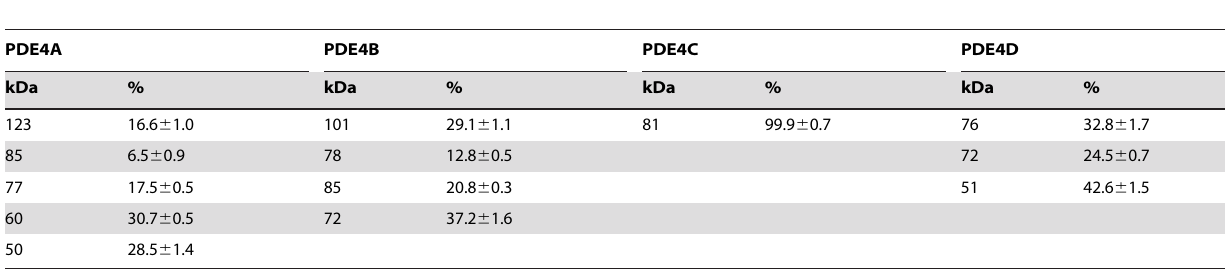
Table 1. Distribution of PDE4A, PDE4B, PDE4C and PDE4D variants in the kidneys of 8 week-old CBA/J control mice.